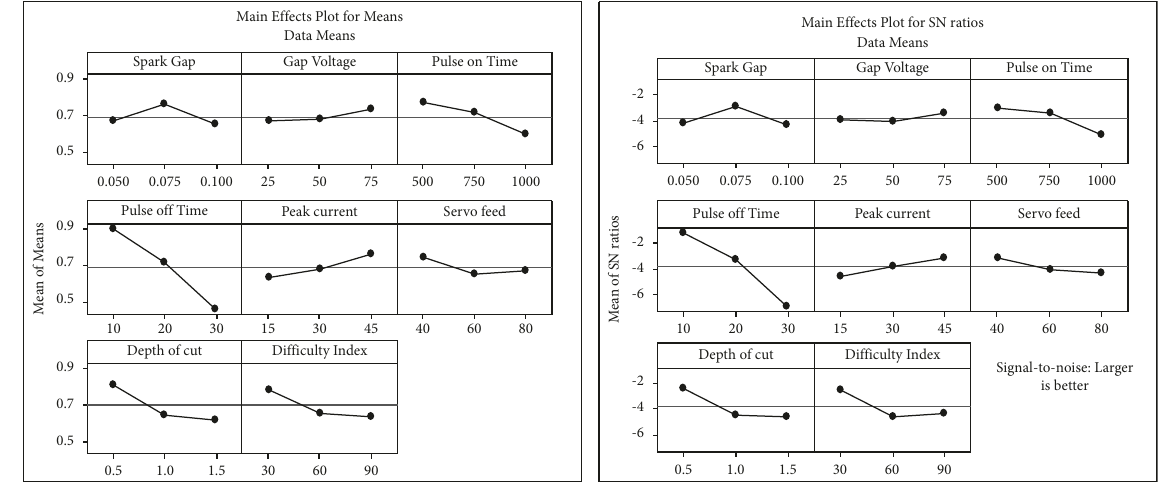
Figure 13: Main effect plot and S/N plot for composite principal component.